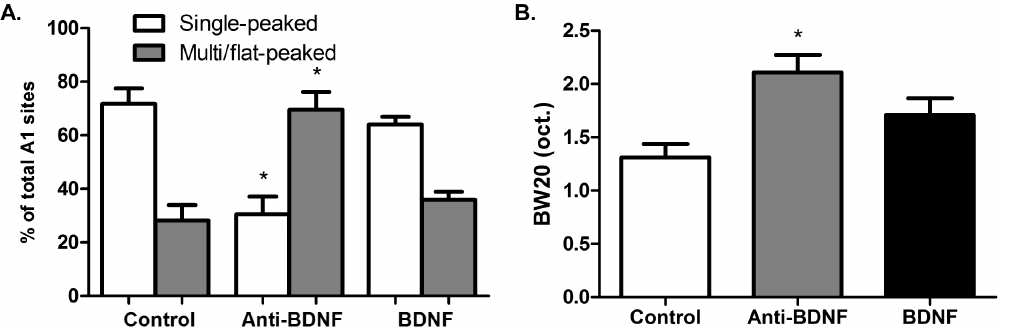
Figure 2. Manipulation of BDNF signaling affects spectral selectivity. (A) Percentage of single and multi/flat-peaked receptive fields for each study group. The percentage of single-peaked receptive fields was significantly reduced in the anti-BDNF group compared to controls (F=13.6, p=0.003, ANOVA). (B) Response bandwidths above threshold (BW20) were significantly augmented in the anti-BDNF group compared to controls (F=7.3, p=0.007, ANOVA). Values are means 6 SEM. * p , 0.05.